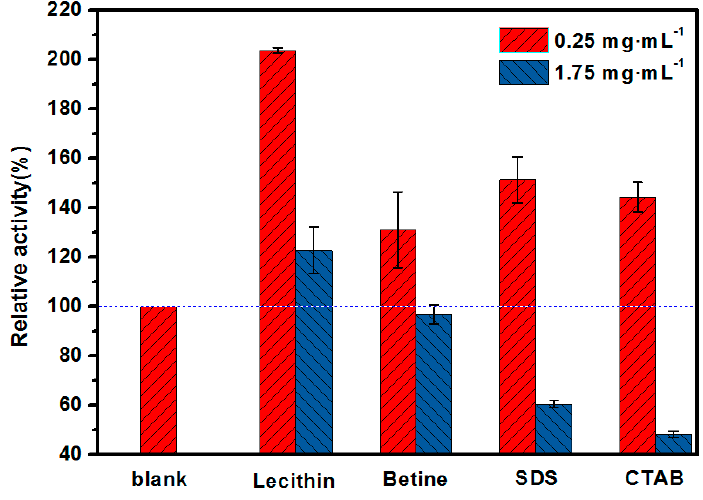
Figure 1. The effect of different charged surfactants on the activity of free lipase.